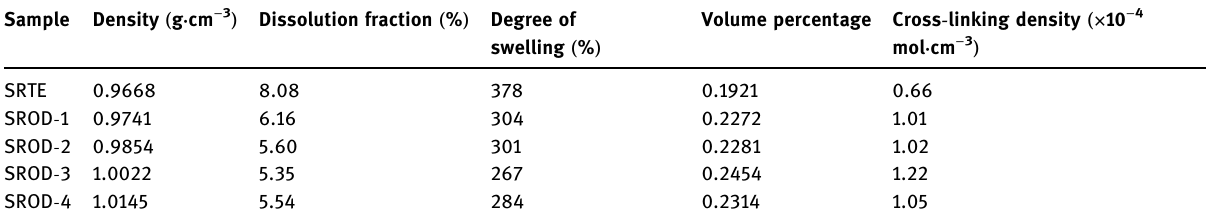
Table 2: Cross - linking density when swollen at equilibrium Sample Density ( g · cm − 3 ) Dissolution fraction ( % ) Degree of